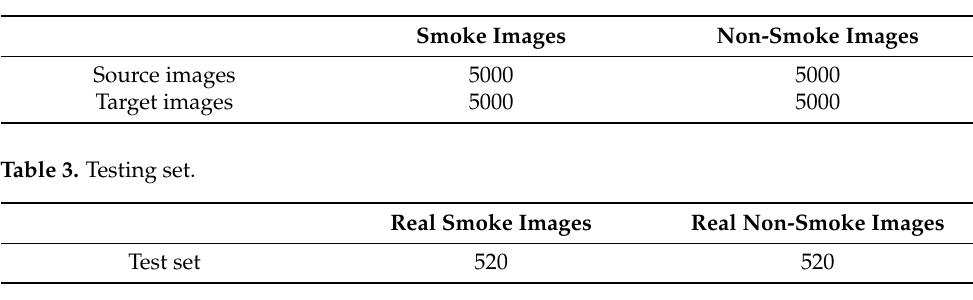
Table 2. Image datasets for feature-level domain adaptation.